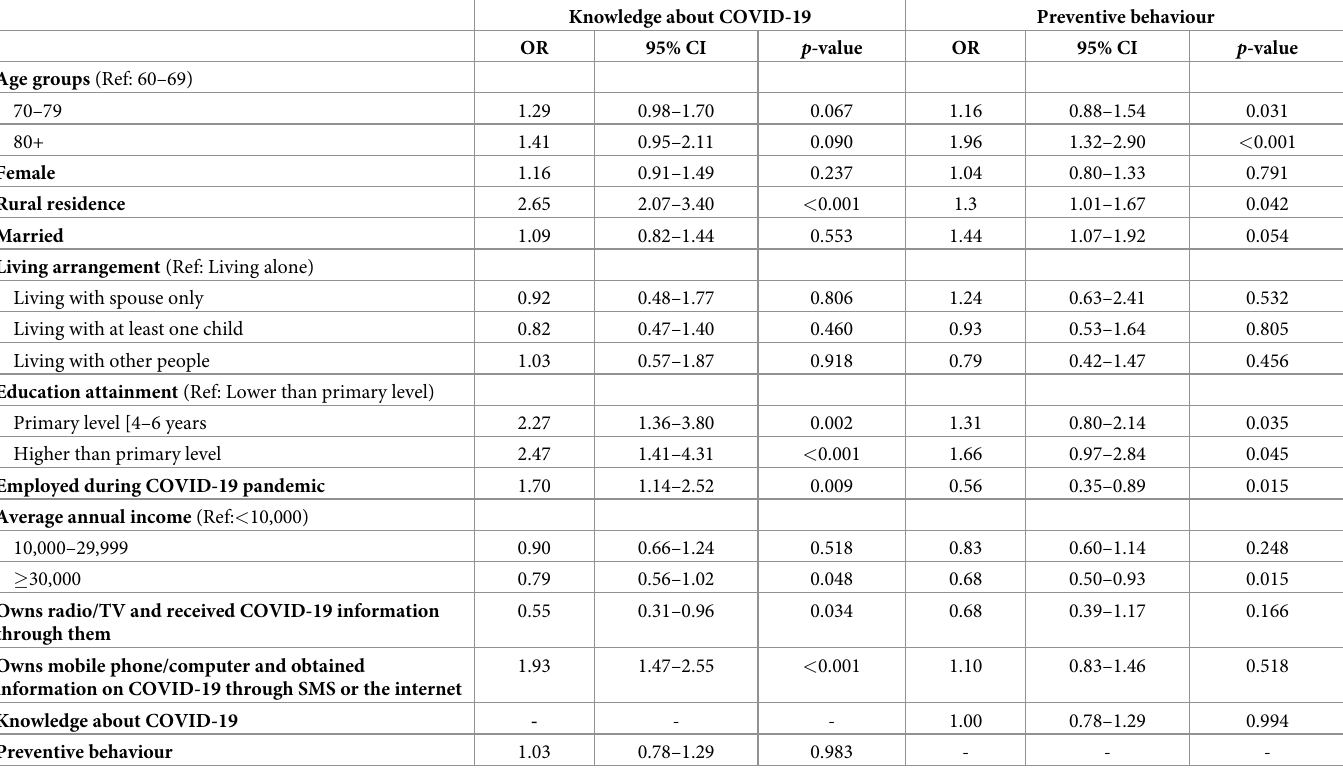
Table 5. Logistic regression model of covariates with knowledge and preventive behaviour regarding